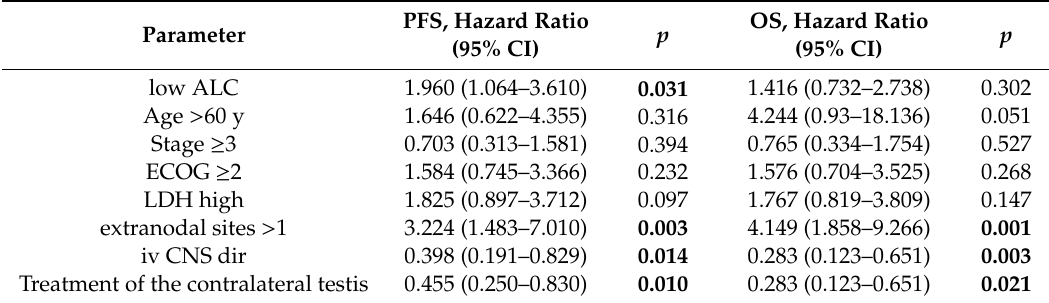
Table 3. Cox regression analyses on the multivariate level of rituximab treated patients showing an independent association of baseline characteristics and treatment parameters with the outcome.